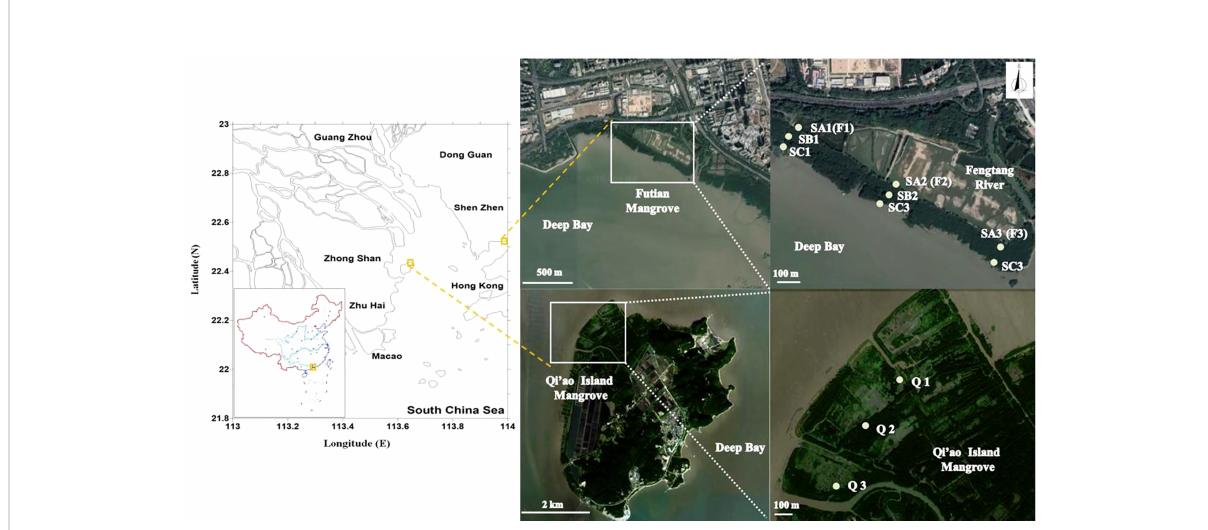
FIGURE 1 The sketch map showing sampling sites in Futian and Qi ’ ao mangrove wetlands. Sediments collected from sites 1, 2, and 3 in Futian were respectively marked as F1, F2, and F3 in spring samples and as SA1, SA2, and SA3 in summer samples, which were at the inner rim of the mature mangrove forest. In summer, the tidal gradient was additionally designed in each site with B in the middle (SB) and C in the outer rim (SC) of the mangrove forest. In Qi ’ ao, only summer samples were collected in three sites at the inner rim of the mature mangrove forest and labeled as Q1, Q2, and